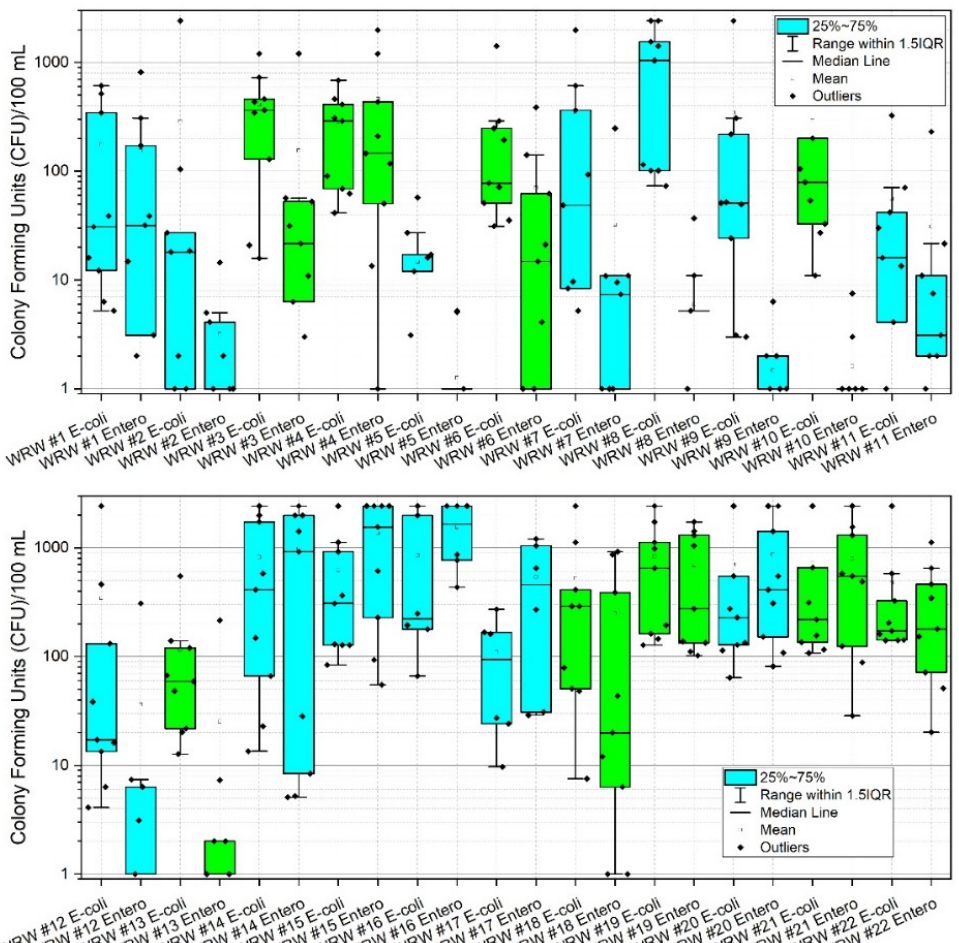
Figure 3. Box and whisker plots of E. coli and enterococci (CFU) at 22 stream monitoring sites during the study period (3 March–3 November 2020) in West Run Watershed, Morgantown, WV, USA. Colony Forming Units (CFU) are as per 100 mL water sample. Blue shaded boxes denote tributaries. Green shading denotes main stem West Run Creek. Log-scale is solely for purpose of improved visualization. Note: to reduce y-axis column heading label length, enterococci are abbreviated